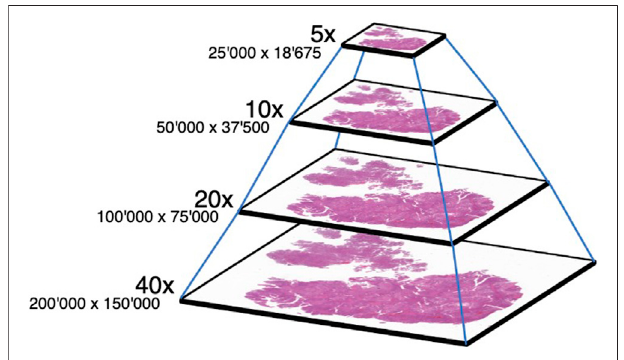
FIGURE 1 | An example of WSI format including multiple magni fi cation levels. The size of each image of the pyramid is reported under the magni fi cation level in terms of pixels.